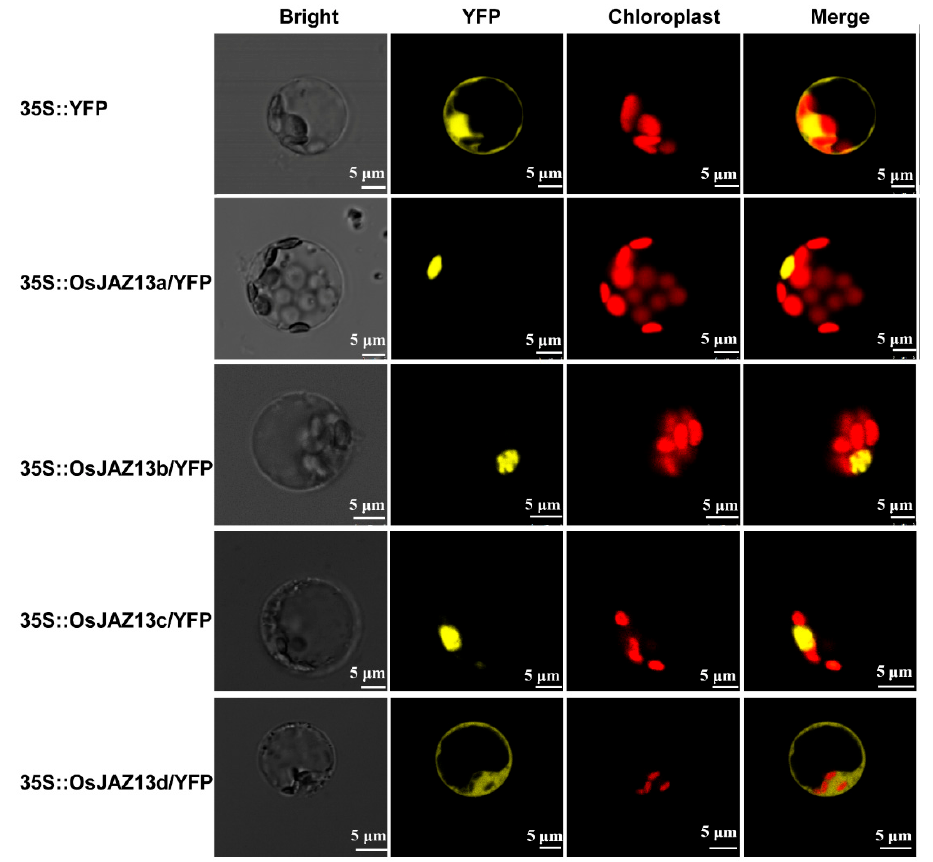
Figure 3. Subcellular localization of OsJAZ13 splice variants. OsJAZ13s-YFP fusion proteins ( pAVA321/35S:: YFP , 35S:: OsJAZ13a/YFP , 35S:: OsJAZ13b/YFP , 35S:: OsJAZ13c/YFP , and 35S:: OsJAZ13d (amino acids 1 to 110 of OsJAZ13) /YFP ) were transiently expressed in rice protoplast. YFP fluorescence was detected, using a confocal laser, after incubation for 24–48 h, in the dark, at 28 °C. Scale bars = 5 µm. This experiment was performed for three independent biological repeats.